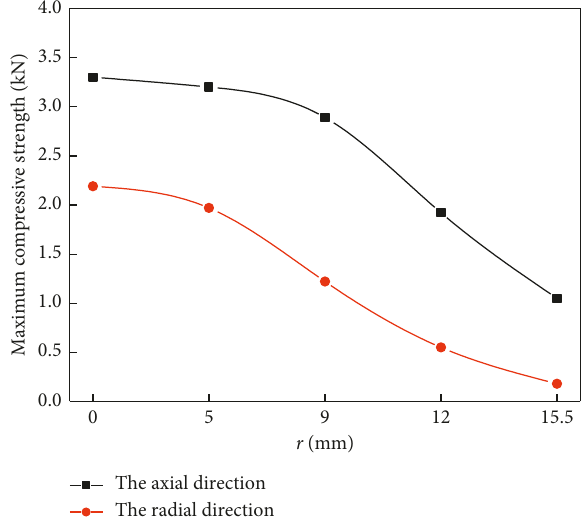
Figure 7: Maximum axial compressive strength and maximum radial compressive strength of hollow-structured oxygen candles.